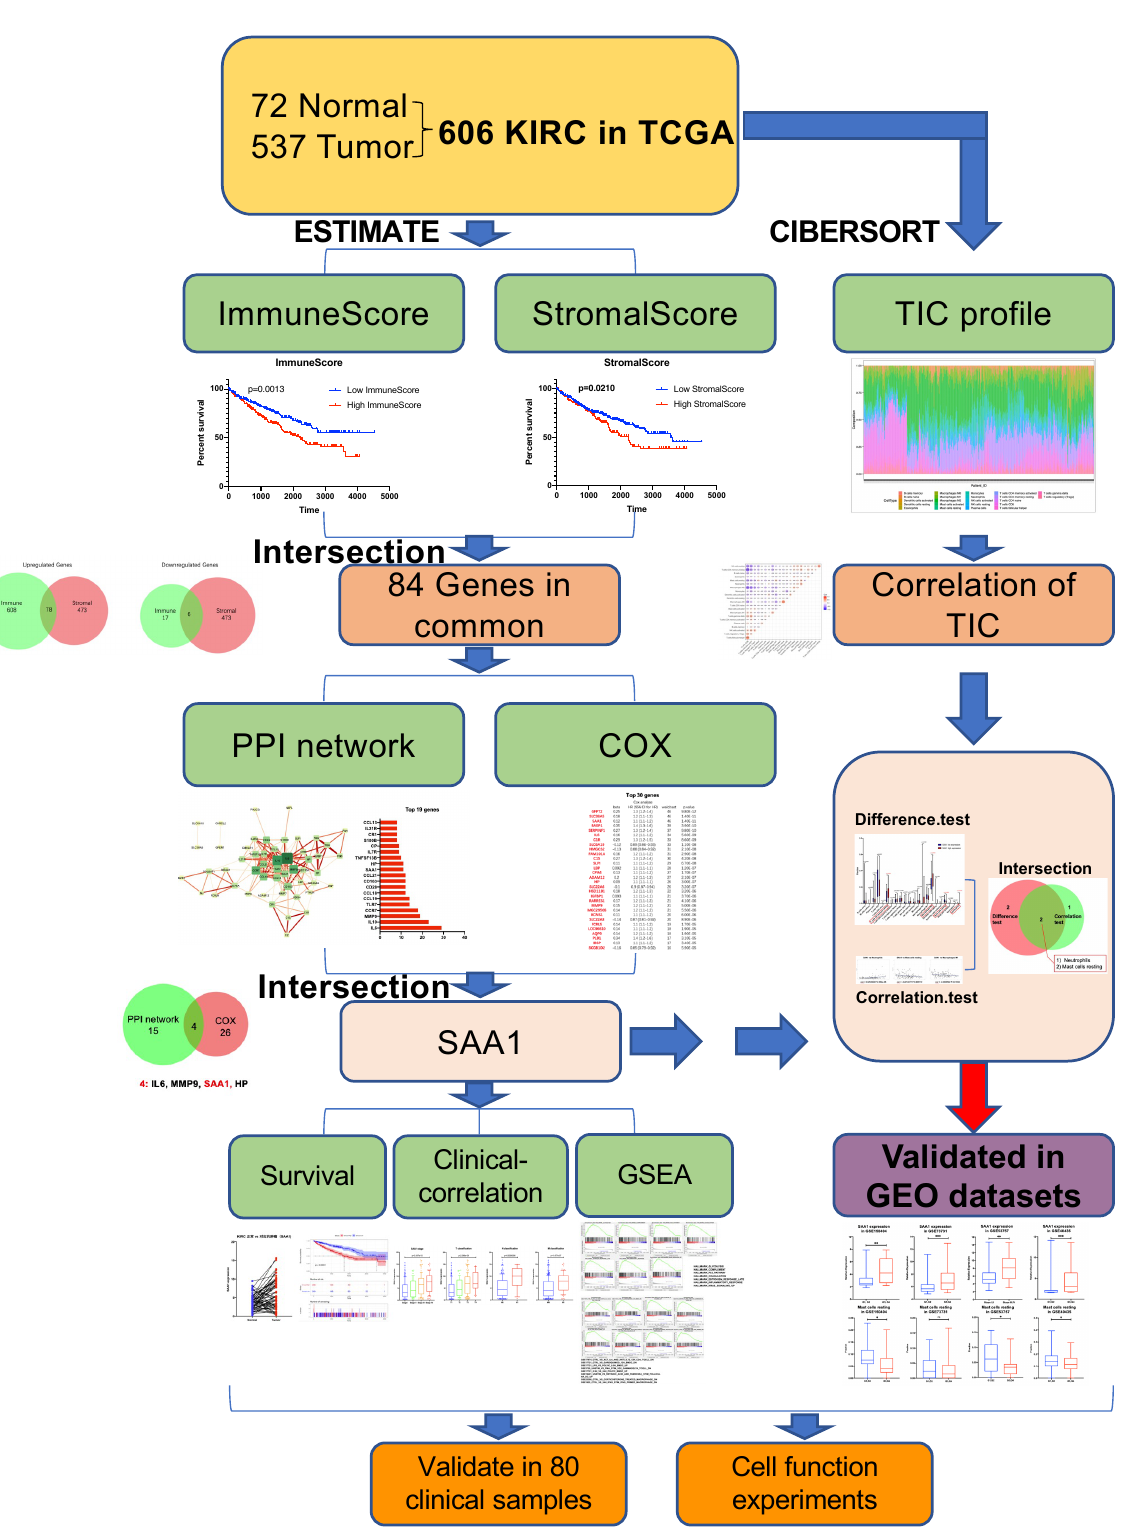
Figure 1. Exhibition of study workflow. TCGA ccRCC data were used in the study and were performed by ESTIMATE and CIBERSORT analysis. Out of the 84 genes in common with ImmuneScore and StromalScore, we found SAA1 was closely related with the survival and clinical features and can be an indicator for immune infiltration of TME. Furthermore, our findings were validated in GEO